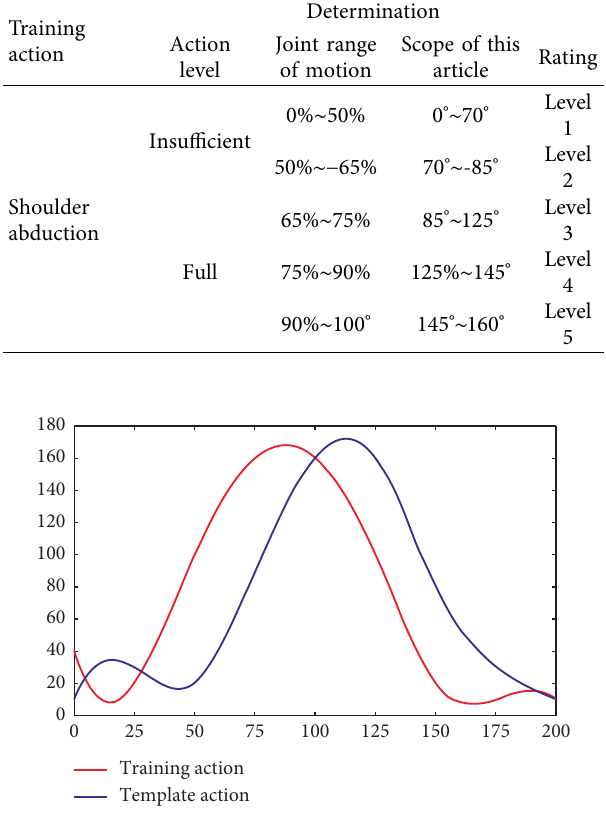
Figure 5: Comparison of joint